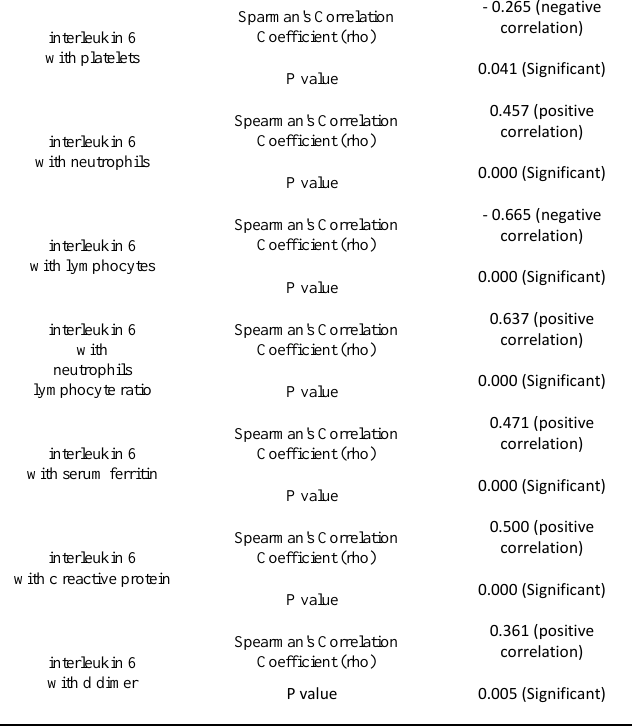
Table 3: Statistical correlations between the 3 groups of patients according to the severity of the disease regarding inflammatory